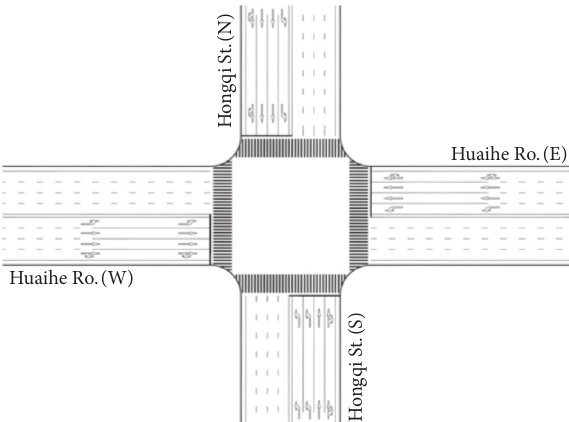
Figure 5: The intersection layout of Hongqi Street and Huaihe Road. Table 2: Conditions of the Hongqi Street and Huaihe Road